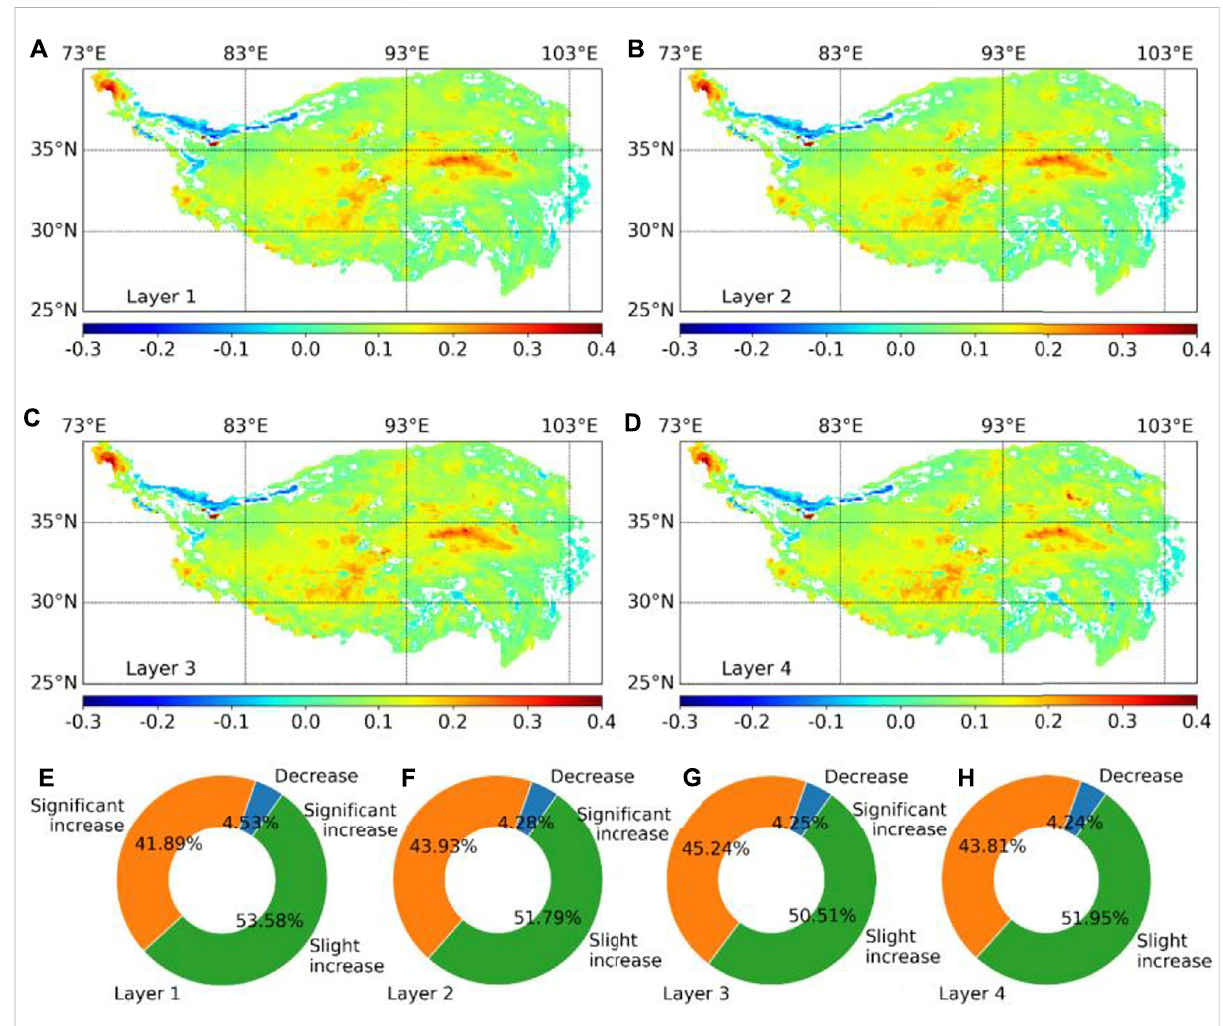
FIGURE 5 (A – D) Spatialdistributionofthesoiltemperaturevariationtrendindifferentlayers.Theunitis ° Cperdecade.Asigni fi cancetestisappliedhereas a mask to fi lter out regions that do not attain 95% con fi dence level. (E – H) Corresponding value percent of (A – D) . Pixel values greater than 0.1 ° C per decade are considered signi fi cant as an increase (rendered in orange), whereas those less than 0 ° C per decade are considered as a decrease (rendered in blue); other values are regarded as a slight increase (rendered in